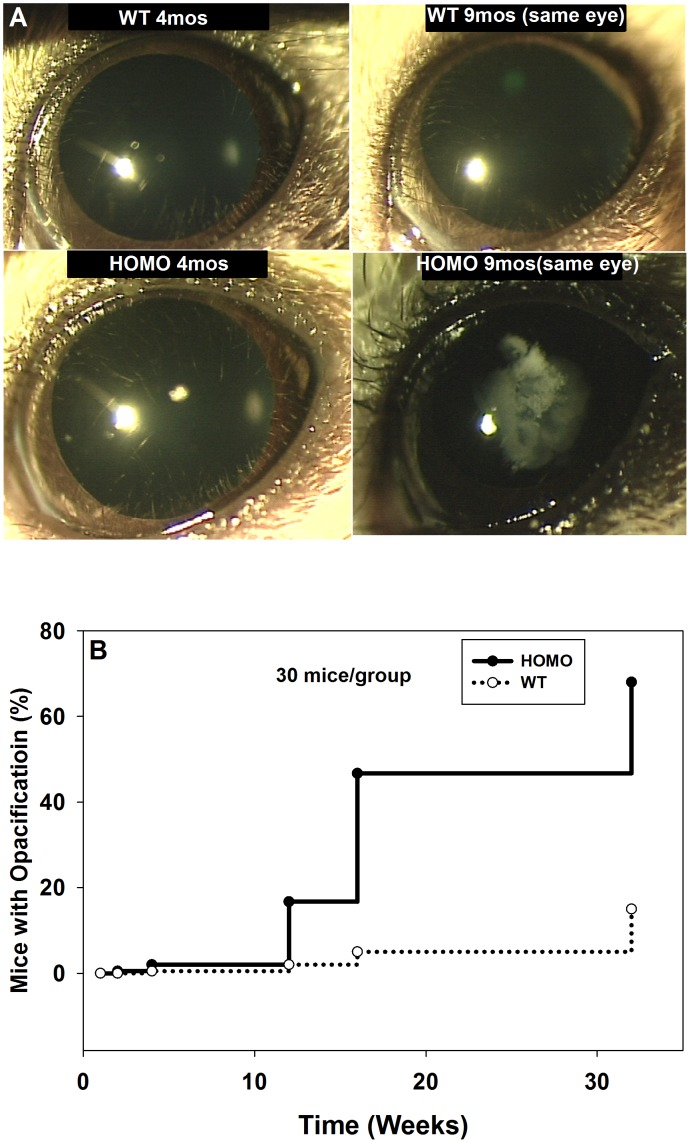
Slit-lamp image of LEGSKO and age matched wild type mouse lens.(A). Representative images of HOM-LEGSKO mouse lens at 4 and 9 months compared with age matched control wild type mouse lens. The same mouse was followed over a period of 9 months and lens images were taken every two months. (B). Slit-lamp images were taken periodically and lens opacity/cataract of any size were recorded for 9 months in homozygous LEGSKO mice vs. age matched wild type mice (n = 30 mice per group). LEGSKO mice developed lens opacities and cataract at much higher rate compared to wild type mice.